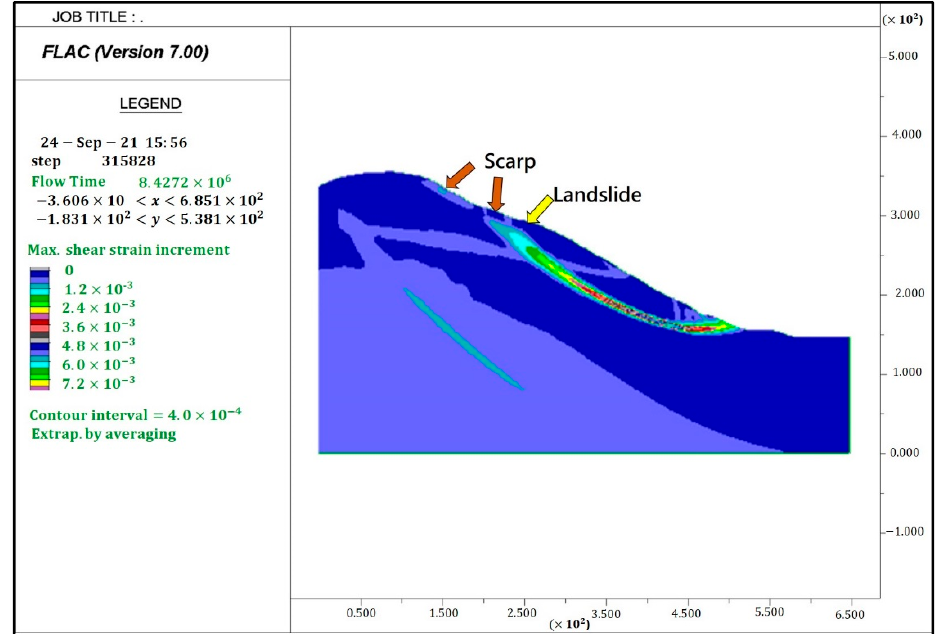
Figure 16. The distribution of the maximum shear strain increment from the numerical model analysis of the proposed slope model with shear zone (state 2). The distribution of the maximum shear strain suggested the location of potential sliding surface, and the location of the shear zone could be observed suggesting larger shear strain developed in the shear zone.